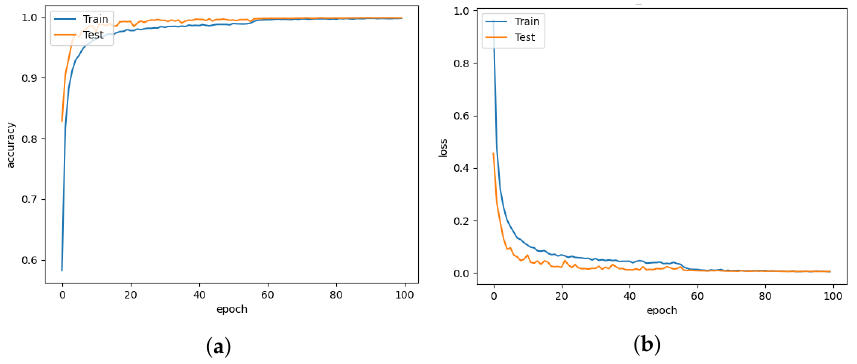
Figure 8. LeNet5 for learning rate = 0.001. ( a ) Model accuracy. ( b ) Model loss.